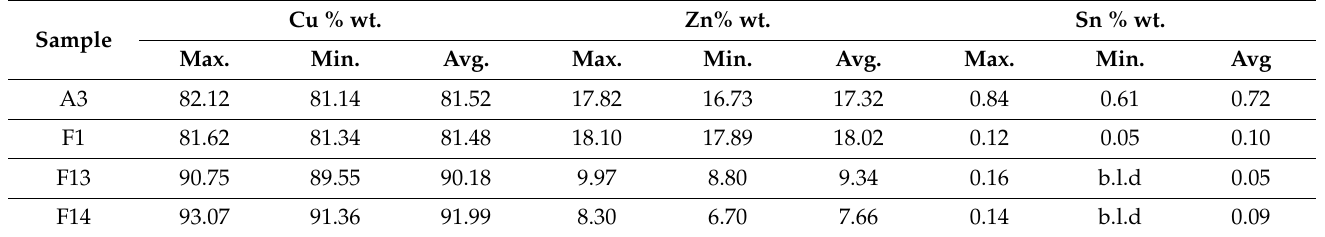
Table 1. Maximum (Max.), minimum (Min.) and average (Avg.) EMP analyses of major elements only in non-corroded areas of the samples. For a comparison with other samples minted from the 1st century BCE and the 1st century CE see [26]. b.l.d.= below detection